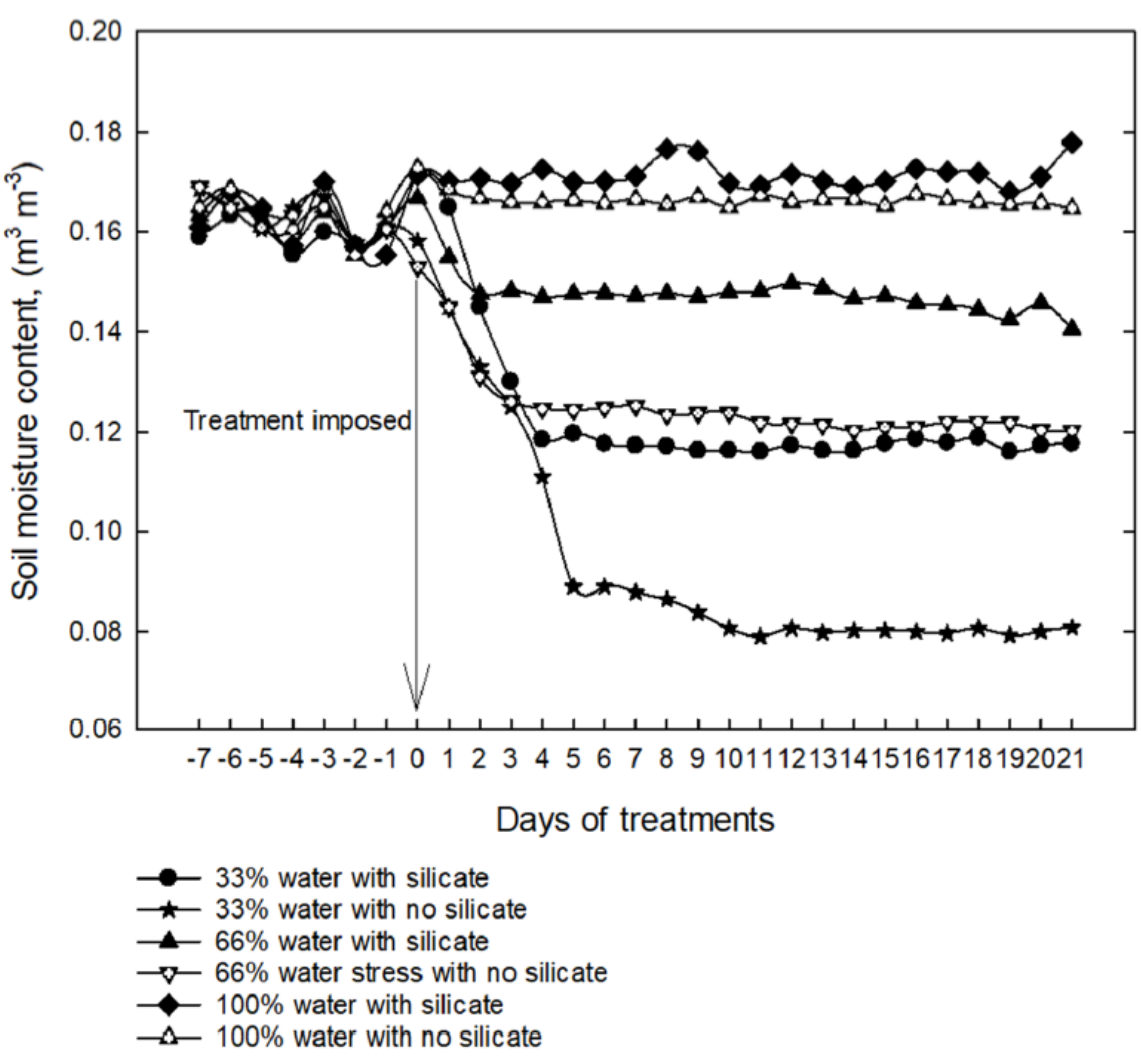
Figure 8. Volumetric soil moisture content in soil growing 7-day-old seedlings under water-limiting conditions. The arrow indicates the day on which water-limiting treatments were imposed.